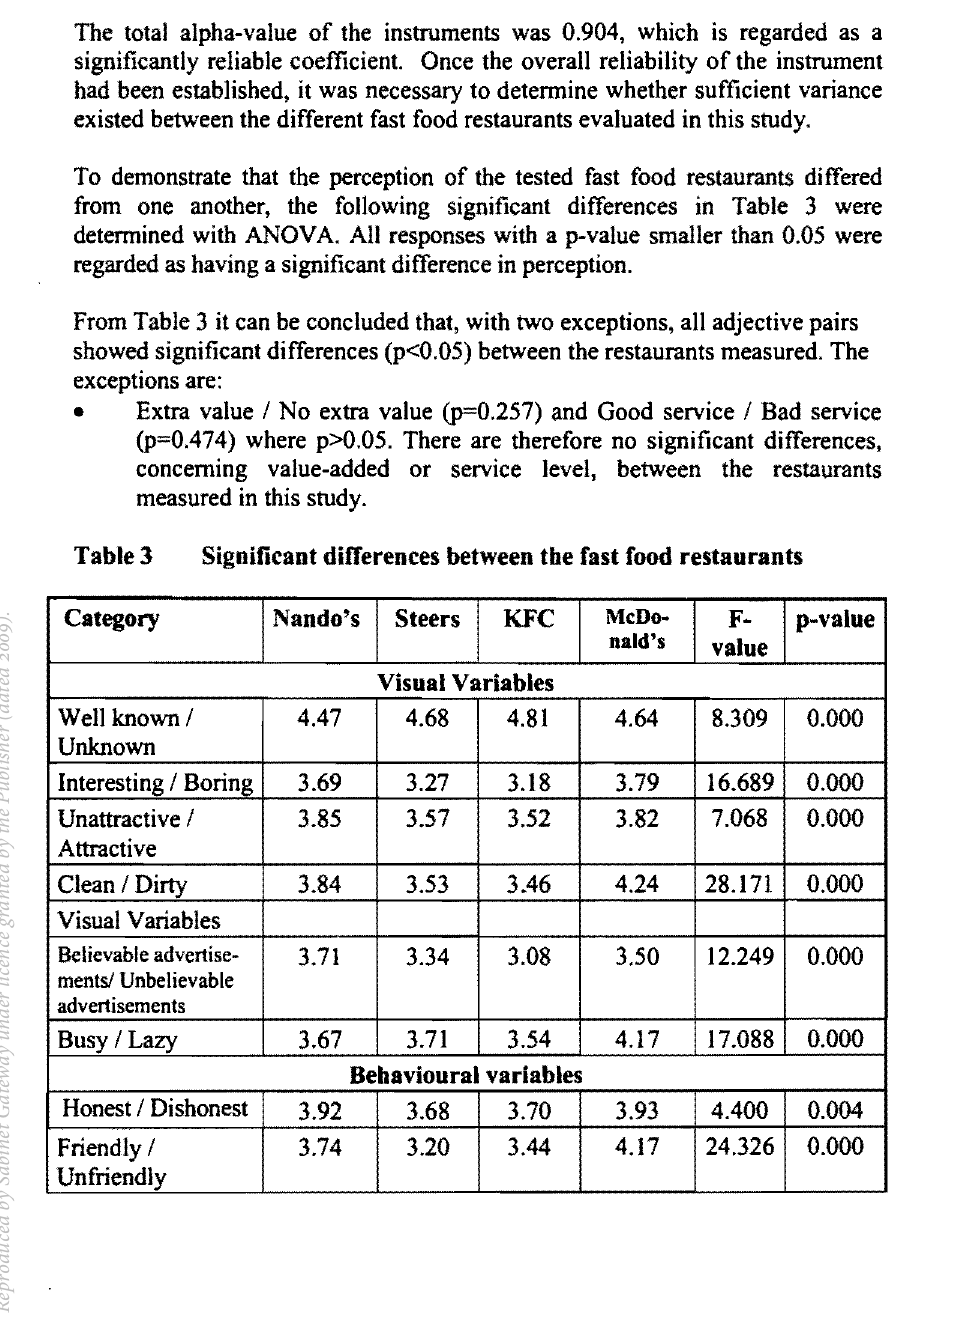
Significant differences between tbe fast food